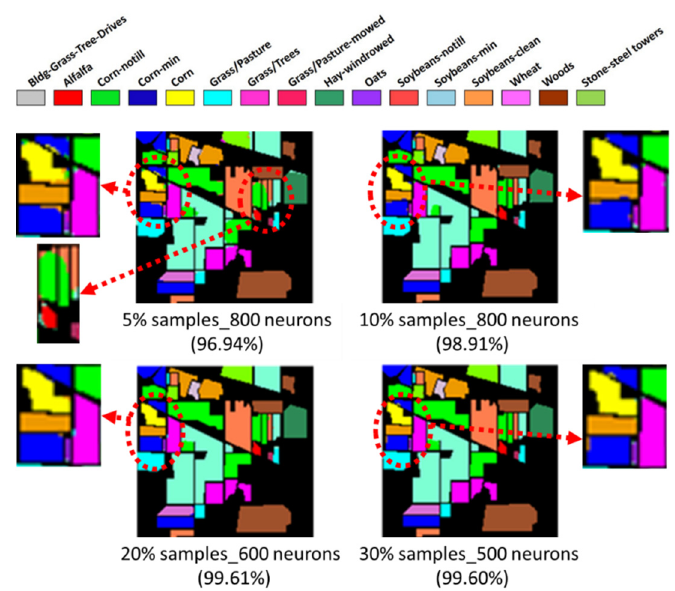
Figure 12. IP MNF1–10 + HHT image classification of the highest accuracies, varying with training sample proportions (the accuracy values are provided in parentheses).